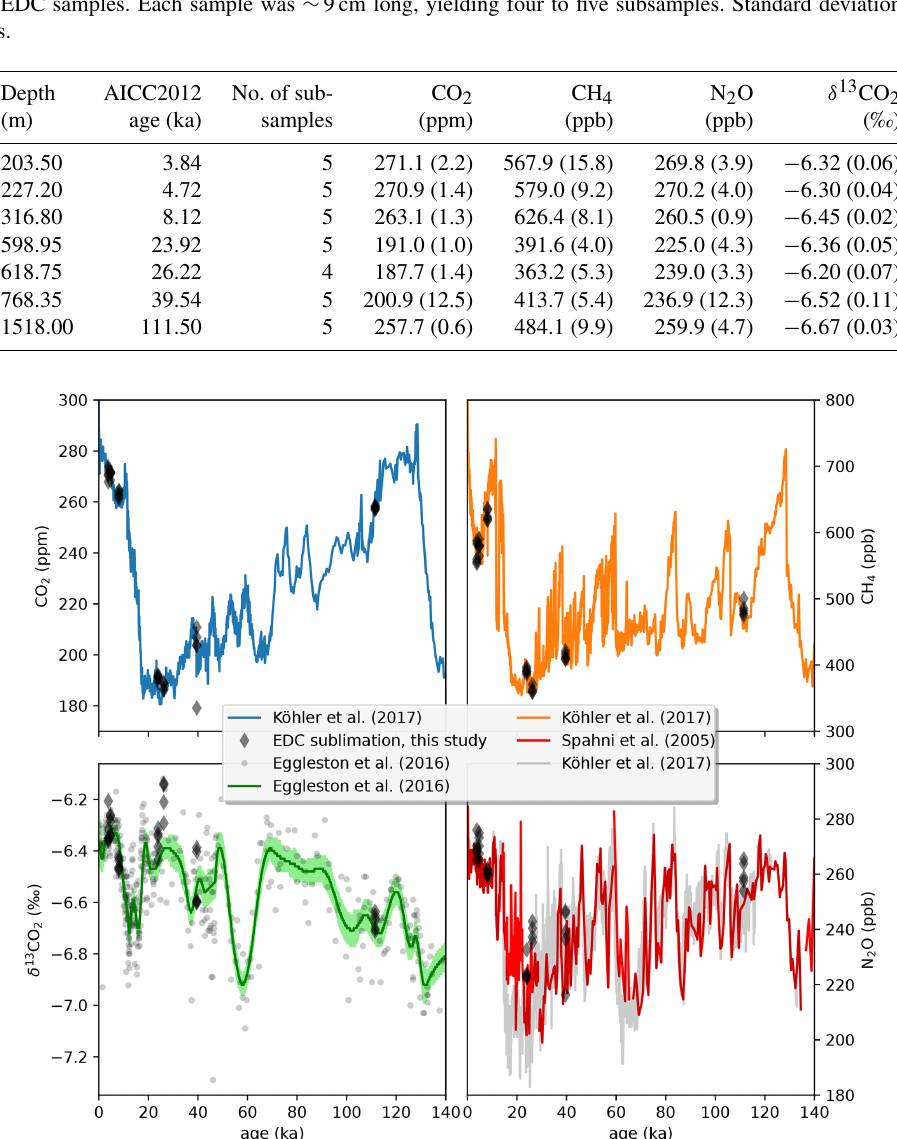
Figure 10. Comparison of selected EDC ice core samples (Table 2) with published records. Reconstructed atmospheric CO 2 and CH 4 data compilations from Köhler et al. (2017). Individual δ 13 CO 2 data points and a smoothing spline are from Eggleston et al. (2016). N 2 O data from Spahni et al. (2005). All LISE/QCLS data are corrected for the extraction biases established by the standard-over-ice experiments. δ 13 CO 2 is additionally corrected for gravitational fractionation using interpolated δ 15 N 2 data from Haeberli et al.